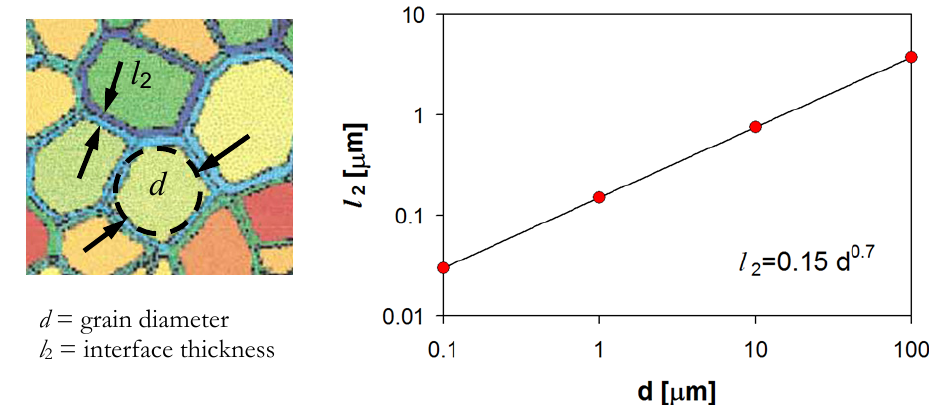
Figure 2: Dependency of the interface thickness on the grain diameter according to the relation proposed in